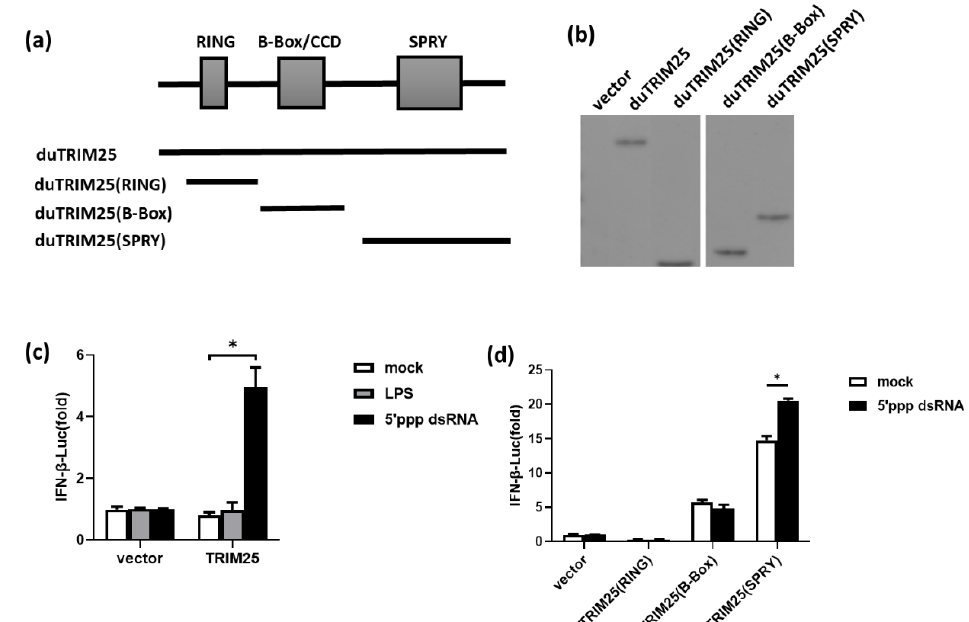
Figure 4. ( a ) Different duTRIM25 mutants were used to construct eukaryotic expression plasmids. TRIM25 represents the ORF of duTRIM25. TRIM25(RING) represents the RING domain of duTRIM25. TRIM25(B-Box) represents the B-box domain of duTRIM25. TRIM25(SPRY) represents the SPRY domain of duTRIM25. ( b ) DuTRIM25, duTRIM25(RING), duTRIM25(B-Box) and duTRIM25(SPRY) were all expressed in DEF cells. Expression of different mutants of duTRIM25 in DEF cells was measured by Western blot. DEF cells were transfected with the duTRIM25, duTRIM25(RING), duTRIM25(B-Box), duTRIM25(SPRY) and pcDNA3.1 + -FLAG plasmids (1 ug each) for 24 h before Western blot analysis. Cell lysates were separated by SDS-PAGE, and different mutants of duTRIM25-FLAG were detected with mouse monoclonal antibodies against the FLAG tag. pcDNA3.1 + -FLAG-transfected DEFs served as a negative control. ( c ) The induction of IFN- β by 5 ′ ppp dsRNA or LPS was further determined. DEFs were co-transfected with pcDNA3.1 + -FLAG-TRIM25 or vector together with pRL-TK Renilla luciferase plasmids and IFN- β luciferase reporter genes for 24 h, and stimulated with 5′ ppp dsRNA, LPS or normal saline as a control for 12 h. Luciferase activity was then measured by a dual-luciferase reporter assay system. ( d ) Characterization of the effect of different domains of duTRIM25 on the induction of IFN- β . DEFs were co-transfected with expression plasmids TRIM25(RING), TRIM25(B-Box) and TRIM25(SPRY) together with pRL-TK Renilla luciferase plasmids and IFN- β luciferase reporter genes for 24 h and stimulated with 5′ ppp dsRNA for 12 h. A dual-luciferase reporter assay system was used to measure luciferase activity. All data are presented as means ± SE ( n = 3). Significance was analyzed by one-way ANOVA with Duncan method (* p < 0.05).